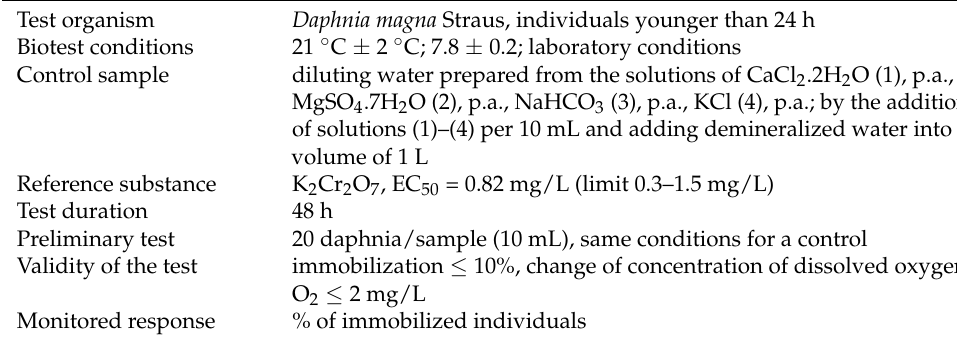
Table 1. The test conditions for Daphnia magna [17–19].